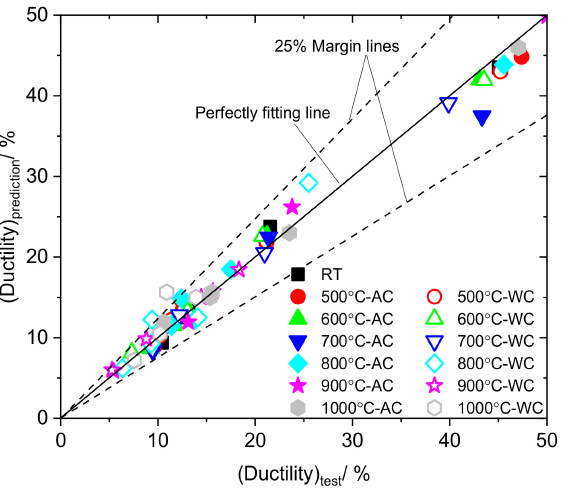
Figure 8. Comparisons of specimen ductility between VGM prediction and